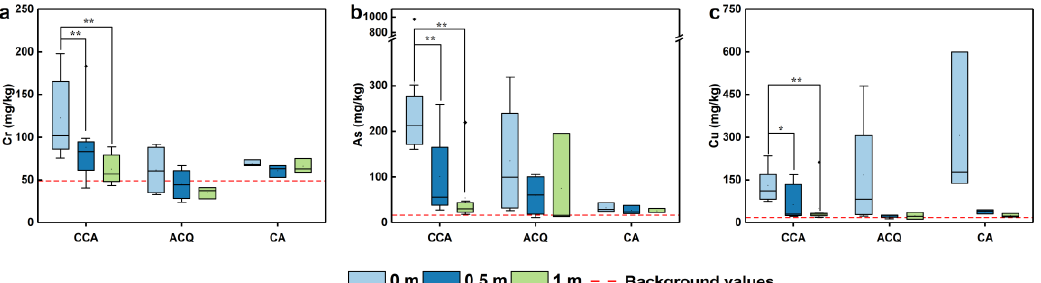
Figure 3. Lateral distribution of Cr ( a ), As ( b ), and Cu ( c ) concentrations in surface soils at a depth of 0 – 10 cm under CCA-, ACQ-, and CA-treated wooden walkways. *, ** indicate significant ( p < 0.05) and highly significant ( p < 0.01)